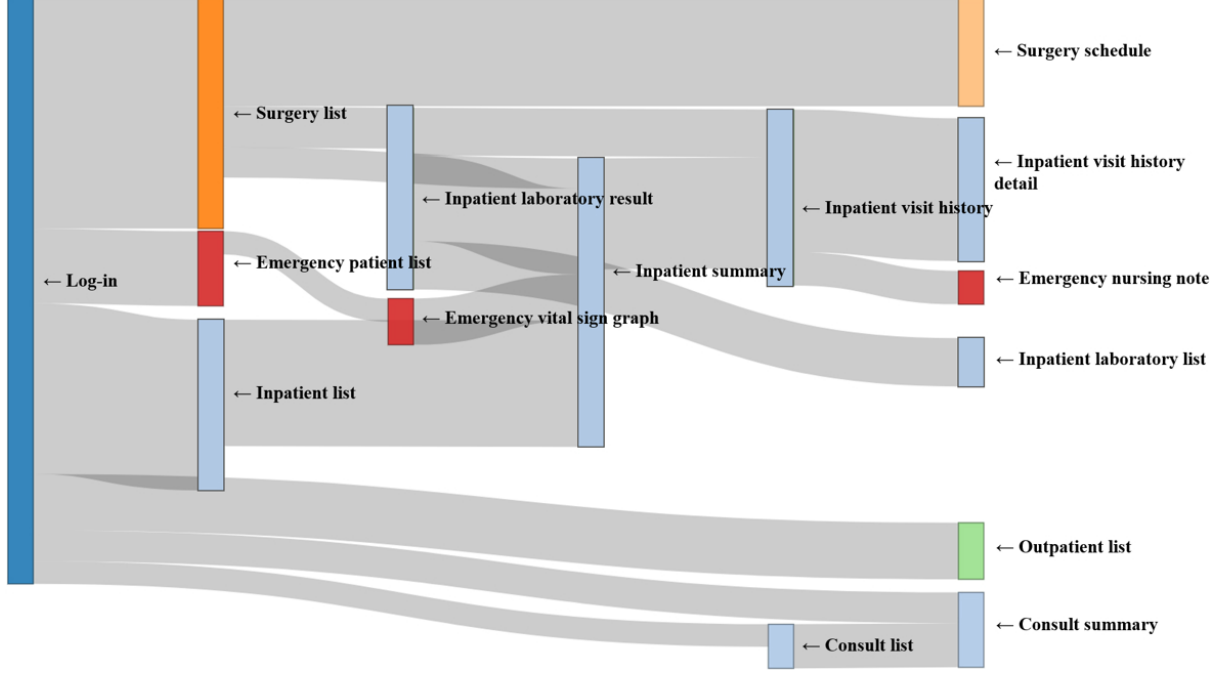
Figure 8. Sankey diagram of usage paths identified for the other hospital-based physicians (OHBP) group. Light blue, light green, light orange, orange and red colors were used to indicate impatient, consult, surgery, outpatient and emergency features, respectively.